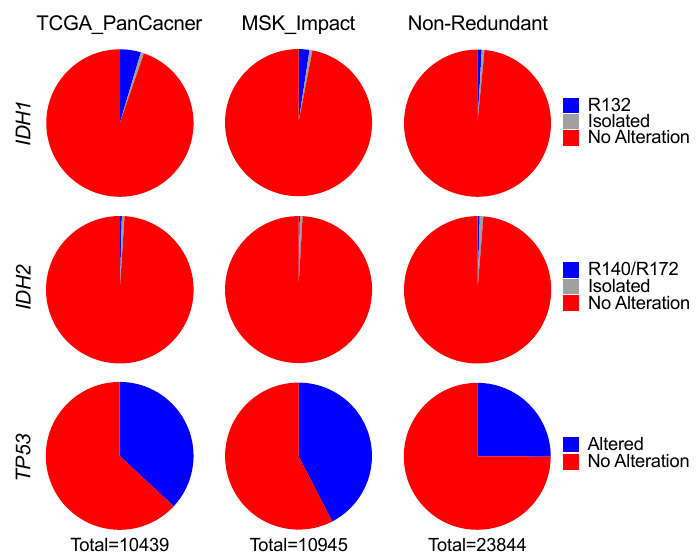
Figure 1. IDH1 and IDH2 alterations are rare in human cancer. Recurrent Arg132 mutation (R132) in IDH1 , isolated genetic events (isolated), and no alteration were extracted from the TCGA_PanCancer, MSK_Impact, and Non-Redundant datasets. IDH2 Arg140 and Arg172 (R140/R172) mutations and TP53 alterations were analyzed similarly.